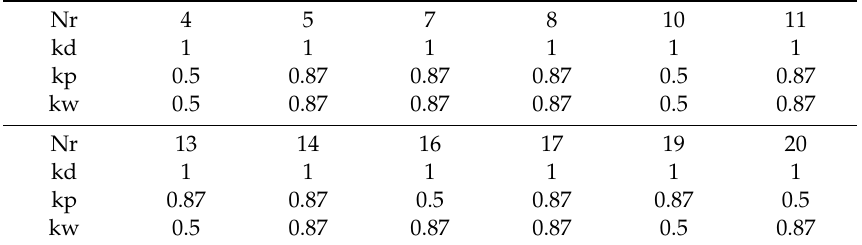
Table 1. Winding Factors of 6-Stator-Slot PS-SF-HMMM with Di ff erent Rotor Pole Numbers.